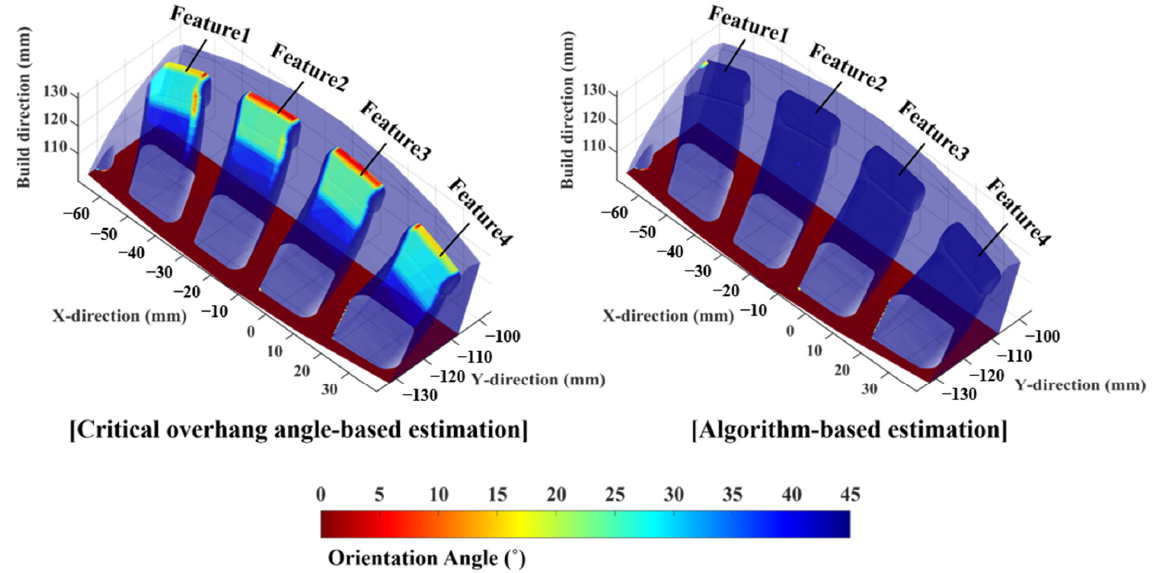
Figure 21. Contours of orientation angle and re-evaluated orientation angle by the algorithm over the surface of sample 1.